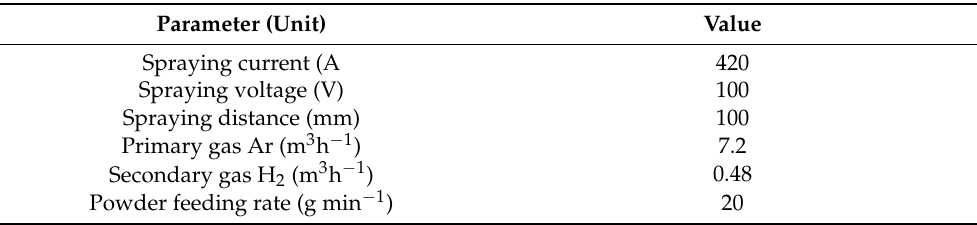
Table 1. Plasma spraying processing parameters for the potassium sodium niobate (KNN) and